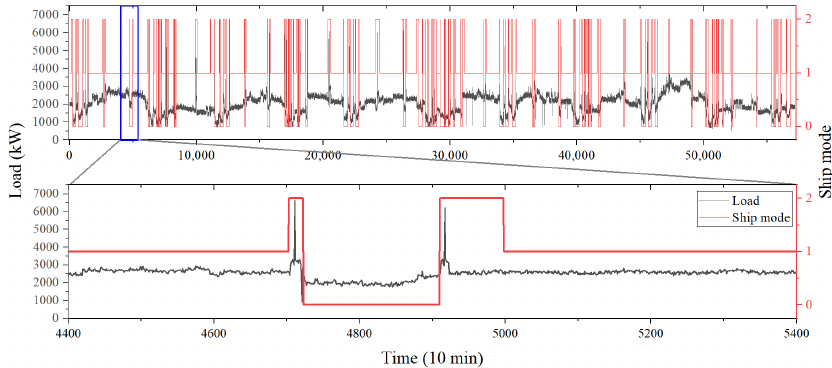
Figure 3. Electric load consumption and ship’s operation mode. Figure 4 is a graph showing as quartiles the distribution of power consumption dur- ing the ship’s operation modes. The horizontal axis of the figure indicates the number of times the operation mode was active during the time the data were acquired.